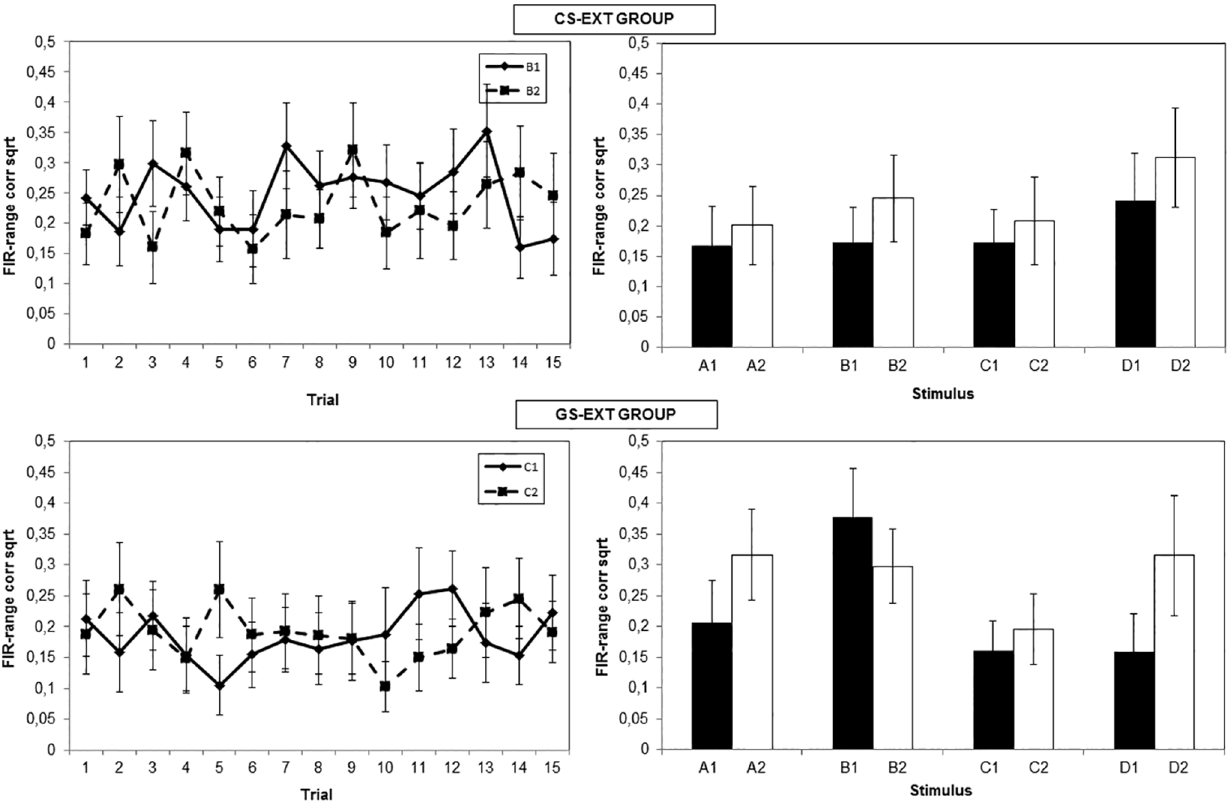
Figure 6. Mean skin conductance responses over the extinction phase and generalization of extinction test. Responses were range- corrected and square-root transformed. The upper graph shows the data of CS-ext group, the lower graph the data of GS-ext group. The left panel represents the data from the extinction phase, per trial, for both B1 and B2 (group CS-ext) or C1 and C2 (group GS-ext). The right panel shows the data from the generalization of extinction test phase of all stimuli from both categories. Each stimulus was presented once during this phase.